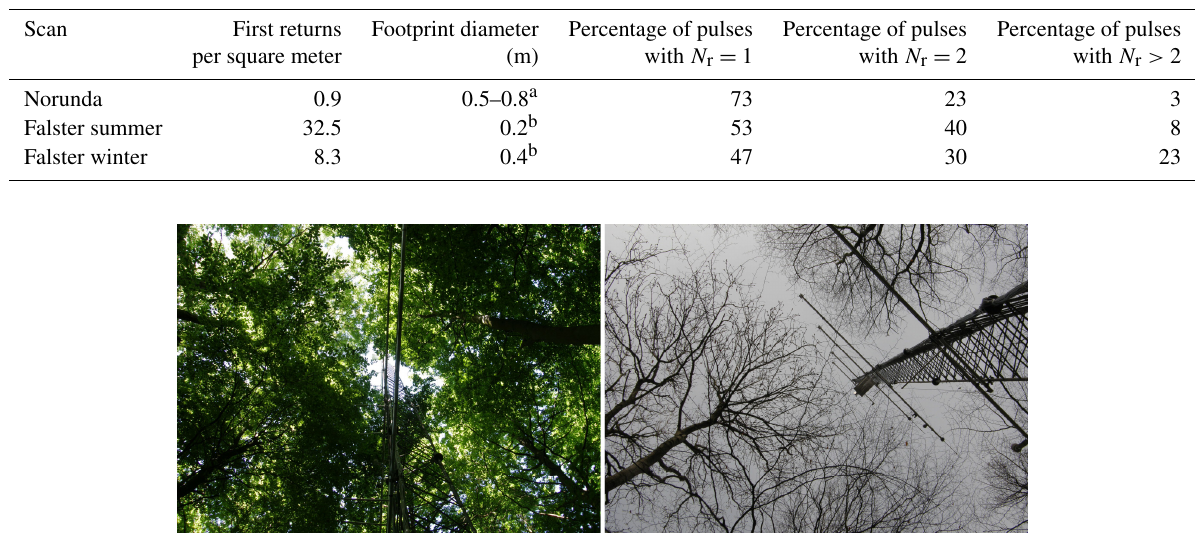
Table 2. Characteristics of the three ALS data sets used in the study. a Lantmäteriet (2016). b Personal communication with Laurids Rolighed J. Laursen, Niras (2017).